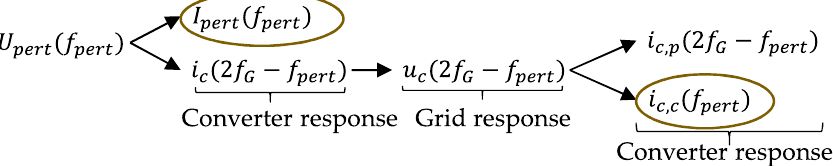
Figure 16. Influence of coupling current on measured current